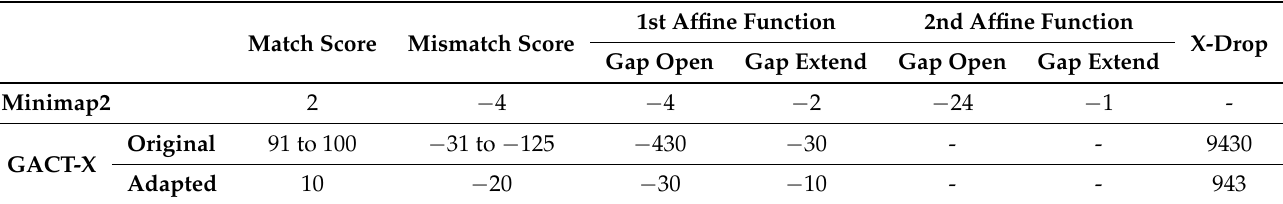
Figure 6. Illustration of GACT-X’s host-FPGA data transfer flowchart. The inputs correspond to many pairs of read and reference anchor-separated sub-sequences (as seen in Section 2.1), which were collected from Minimap2 after the seeding and chaining steps (left of the figure). The sequence of steps for the software–hardware interaction is as follows: (1) sequential transfer of each anchor- separated sub-sequence from the host server to the FPGA board into the “ref_seq” and “query_seq” buffers; (2) the execution of each anchor-separated sub-sequence with a looped data transfer between the host and the FPGA, corresponding to the number of tiles. For this looped execution (5 tiles): (a) the host sets the tile’s starting indexes with variables “ref_offset” and “query_offset”, and the tile’s size with variables “ref_len” and “query_len”, sending them to the FPGA; (b) the FPGA kernel calculates the alignment for the tile and writes the alignment score, the maximum score’s indexes with variables “ref_pos” and “query_pos”, and the number of trace-back pointers in the band back to the host, all from the “tile_output” buffer. The trace-back pointers are transferred from the “tb_output” buffer. Table 2. Minimap2 and GACT-X’s alignment